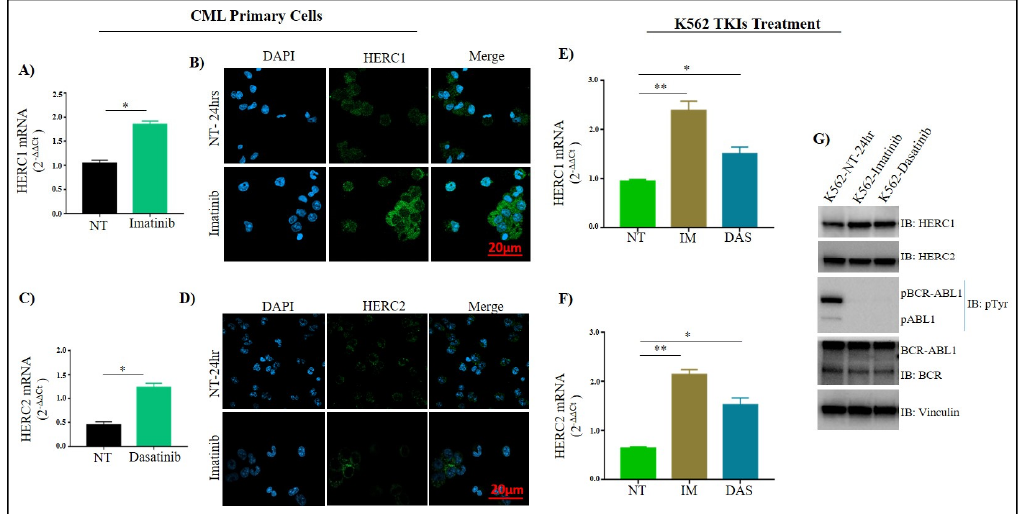
Figure 4. Effect of Imatinib and Dasatinib treatment on HERC1 and HERC2 expression in primary CML and K562 (Ph+) cells. The HERC1 and HERC2 gene expressions following Imatinib (1 μ M) and Dasatinib (0.25 μ M) treatment were determined at mRNA and protein level by RT-qPCR ( A , C , E , F ), immunofluorescence ( B , D ), and Western Blotting ( G ). Imatinib (1 μ M) and Dasatinib (0.25 μ M) treated K-562 cells (24 h) showed an increase in HERC1 gene expression both at mRNA and protein levels compared to non-treated cells, in contrast, an increase in HERC2 mRNA was observed without any change in its protein level. TKIs impaired the phosphorylation (enzymatic actively) of BCR-ABL, which indicates the HERC1 protein and mRNA levels of both HERCs are modulated by the activity of Bcr-Abl1. Vinculin was used as a loading control in Western blot. p ≤ 0.05 = *; p ≤ 0.01 = **.